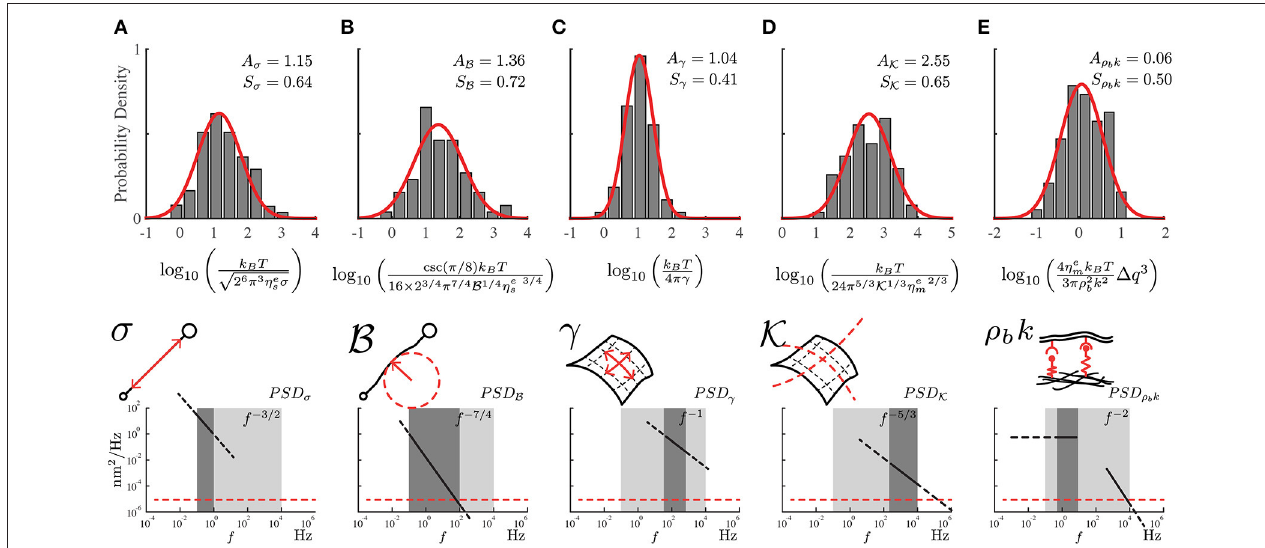
FIGURE 3 | The probability distribution of the mechanical properties for the PC12 cell neurites using the local power-laws and amplitudes for each frequency regime. (A) Axial tension σ , (B) Flexural rigidity B . (C) Plasma membrane surface tension γ . (D) Plasma membrane bending K and (E) Membrane to cytoskeleton coupling ρ b k . The mechanical parameters are represented in the sketches including the approximate range of frequencies and the theoretical power-laws for each one of them (dark gray region). The light gray region represents the range of available frequencies while the red segmented line represents the low detection limit of the instrument. The samples were prepared weekly, we recorded four to six neurites per week reaching a total of 75 neurites ( N = 75).